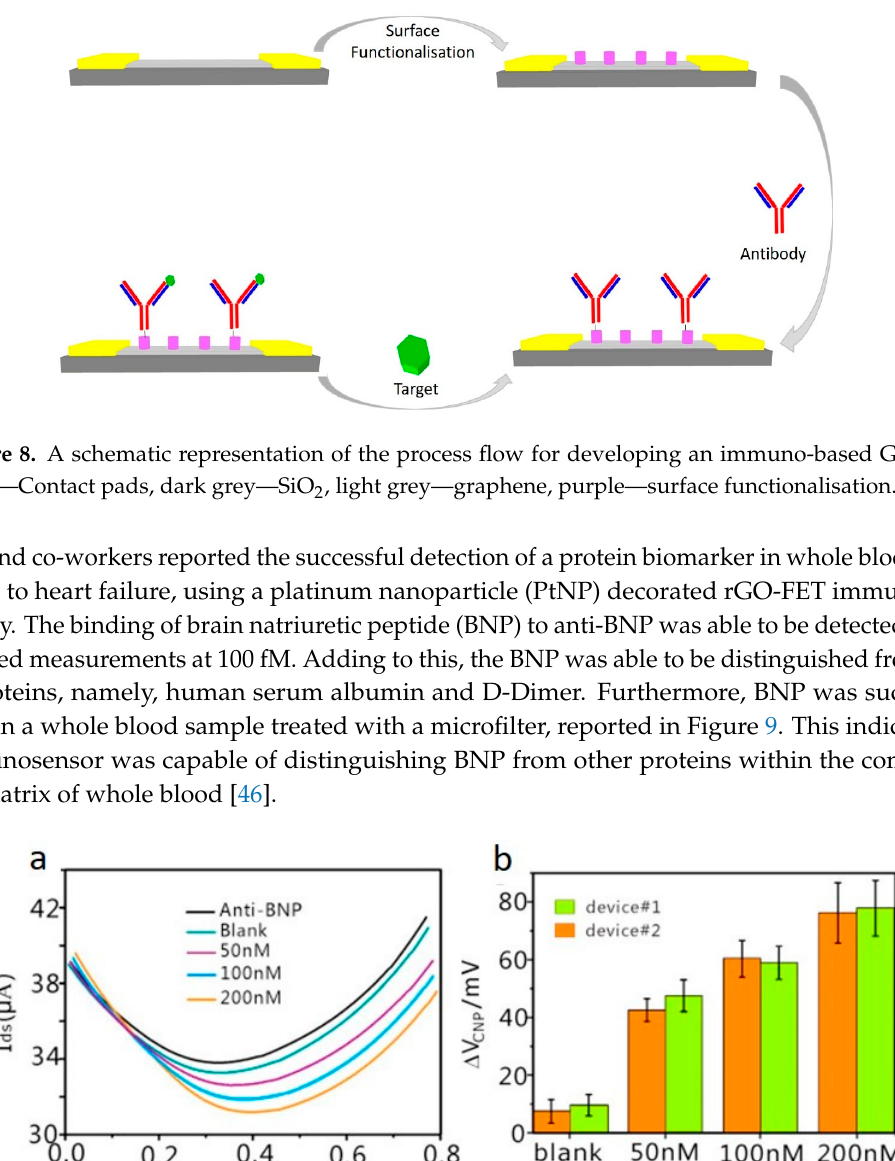
11 of 18 Figure 7. ( a ) The transfer curve of a G-FET decorated with AuNPs with immobilized PNA probe when exposed to increasing concentrations of Let7b miRNA. ( b ) It can be noted that V D progressively decreases in V g due to an n-doping effect of the graphene by miRNA hybridization. Reprinted from [41],